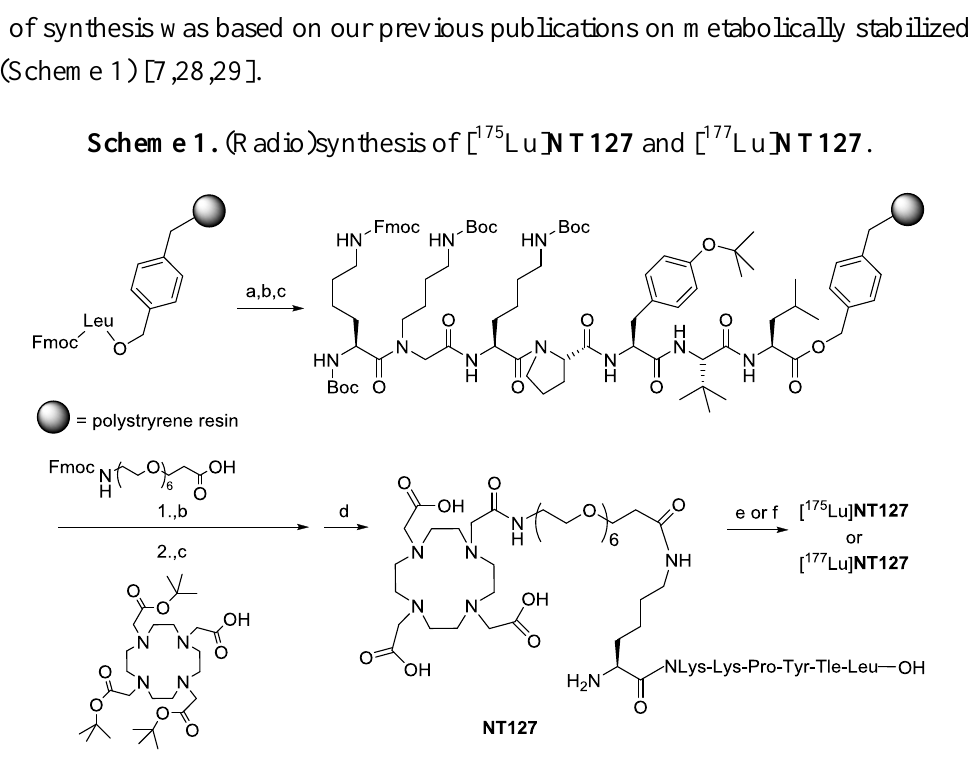
Cl (3:7); (3) TFA, 2 2 ) , 0.5 M HEPES pH 5, 98 3 3